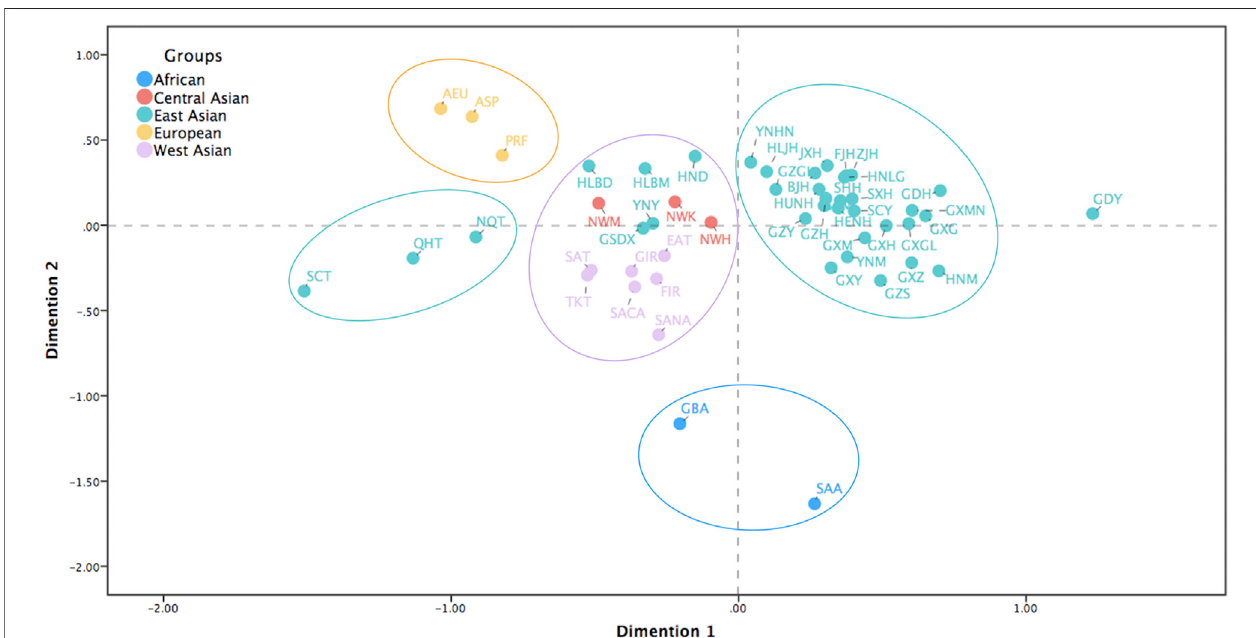
FIGURE 6 | MDS analysis for the Northwest Hui group and the reference populations without the reference Hui groups from Chinese different regions based on pairwise R st values. MDS, multidimensional scaling.